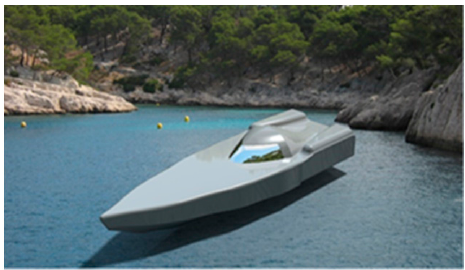
Figure 1. Unmanned ship structure. Table 1. Unmanned ship hull parameter.